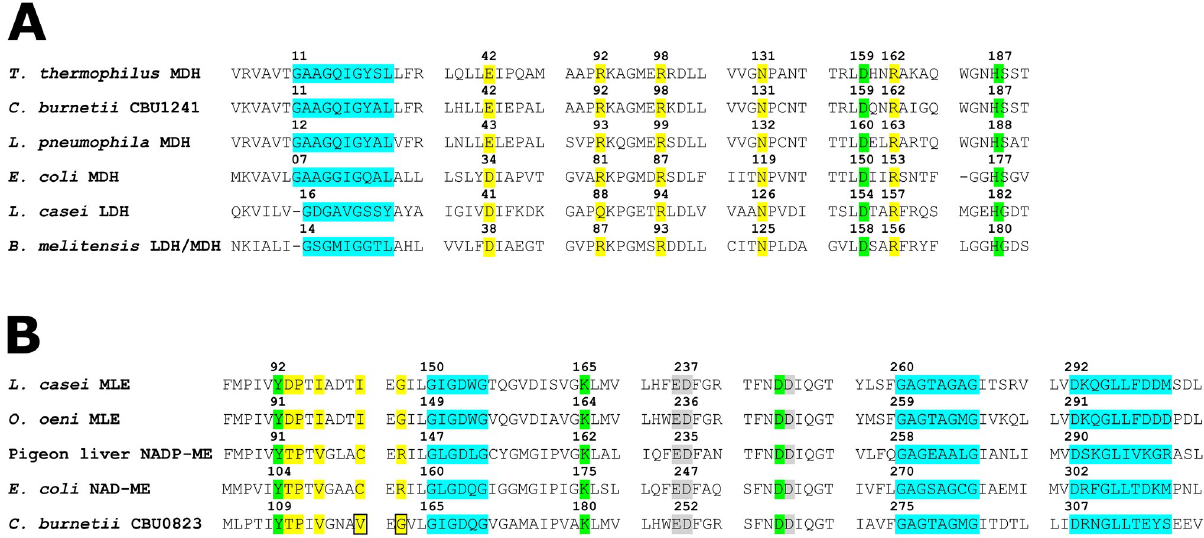
Fig 2. Key residues of CBU1241 and CBU0823. Protein sequence alignment sections containing key residues of (A) CBU1241 compared with MDHs and LDHs and (B) CBU0823 compared with MEs and MLEs. The NAD(P)-binding motifs (blue), substrate binding residues (yellow), catalytic activity residues (green), and metal binding residues (grey) are highlighted, and the boxes indicate unusual residues present within CBU0823 versus other bacterial MEs. Numbering refers to the residue position within the respective protein.